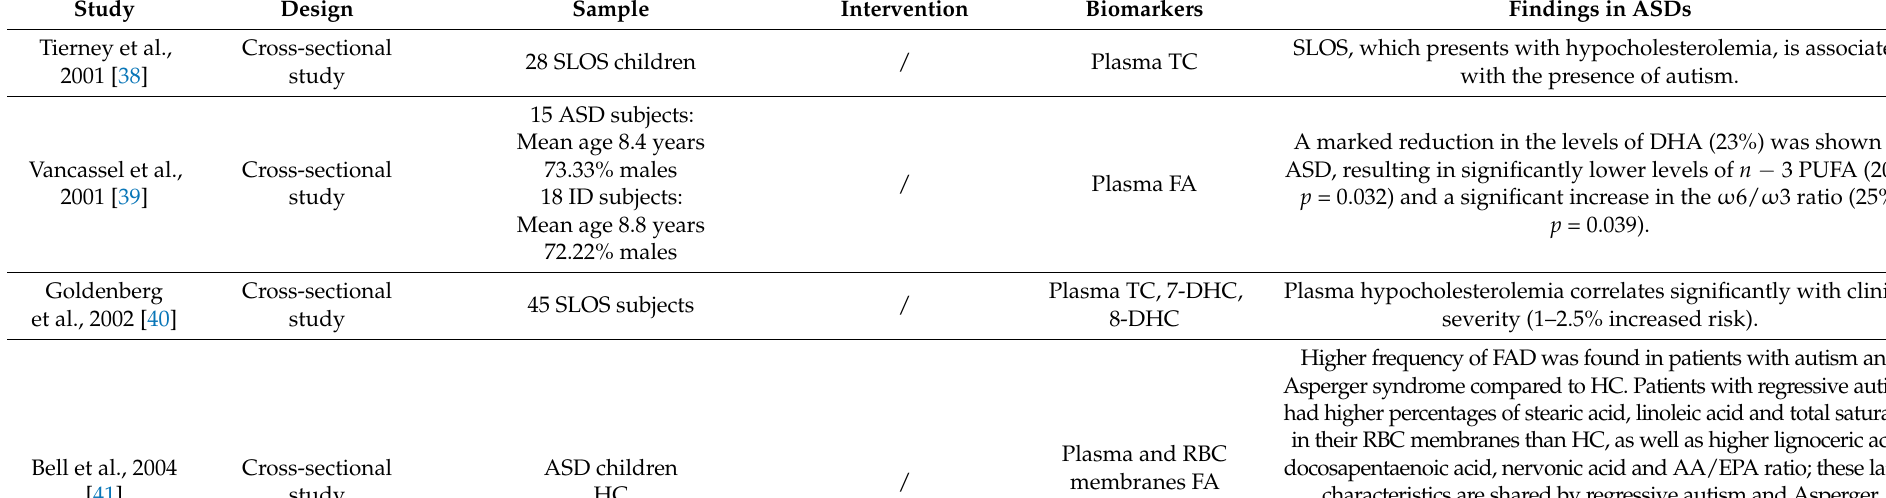
Plasma hypocholesterolemia correlates significantly with clinical severity (1–2.5% increased risk). Higher frequency of FAD was found in patients with autism and Asperger syndrome compared to HC. Patients with regressive autism had higher percentages of stearic acid, linoleic acid and total saturates in their RBC membranes than HC, as well as higher lignoceric acid, docosapentaenoic acid, nervonic acid and AA/EPA ratio; these latter membranes FA characteristics are shared by regressive autism and Asperger composition syndrome. Patients with regressive autism showed lower oleic acid and AA values and patients both with regressive autism and with Asperger syndrome presented lower docosapentaenoic acid and total n − 3 PUFAs compared to HC. Asperger subjects showed statistically significant elevated levels of TC, LDL-C and TG and significant lower levels of HDL compared with HC. After controlling for physical activity, group differences remained significant for TC ( p = 0.016) and LDL-C ( p = 0.017), but